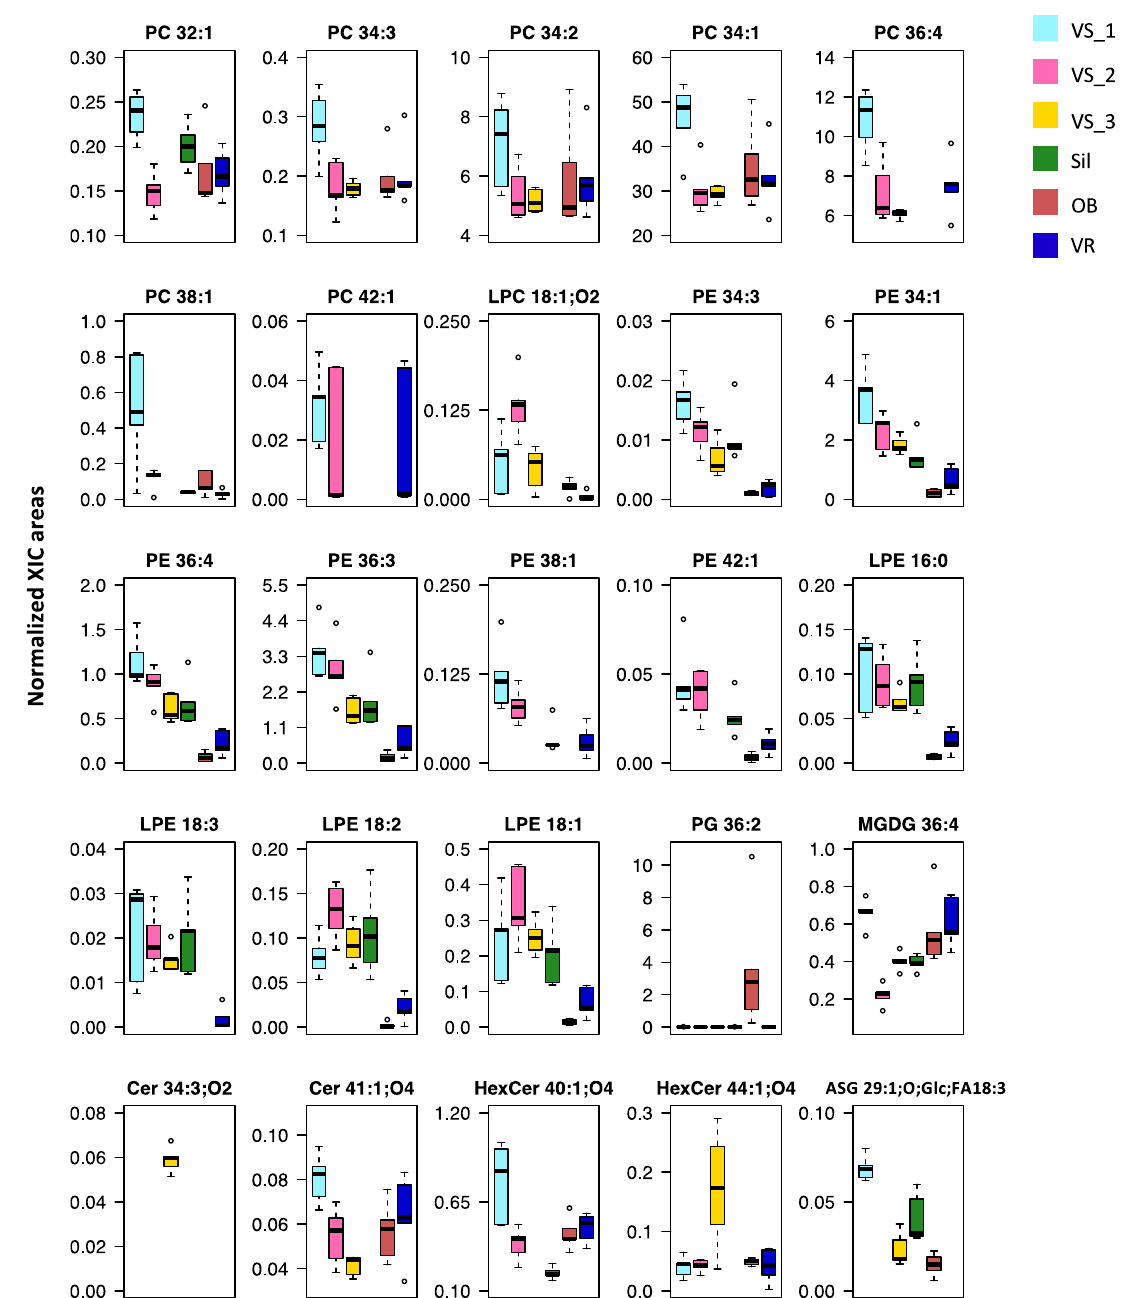
Figure 5. Boxplots of the top 25 polar lipid species sorted by the lowest q values. Normalized areas were obtained from extracted-ion chromatograms (XIC). The boxes represent medians and 25th and 75th percentiles. Error bars represent range (from the minimum to the maximum value), and dots are outliers. Sub-region abbreviations: Oliveira de Barreiros (OB), Silgueiros (Sil), Vila Ruiva (VR), Vilar Seco_1 (VS_1), Vilar Seco_2 (VS_2), and Vilar Seco_3 (VS_3).